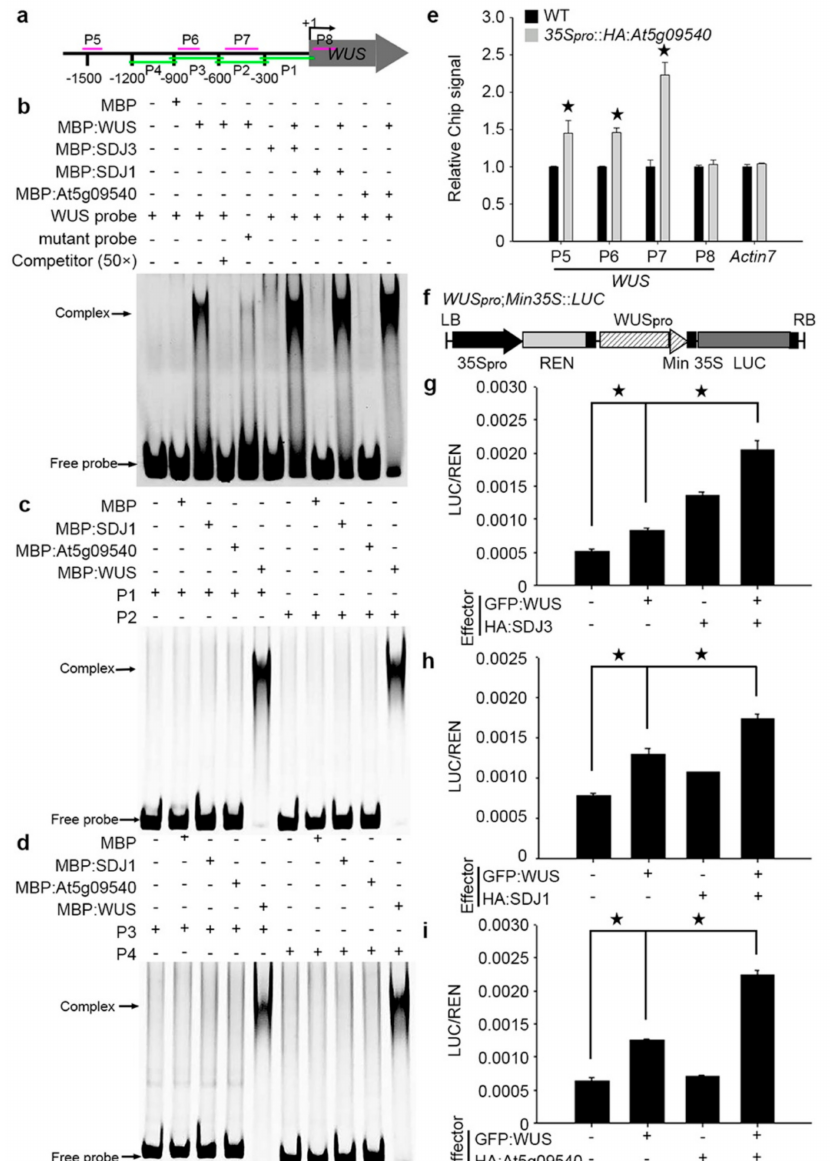
Figure 2. WUS-DnaJ complexes bind to WUS promoter and regulate WUS promoter activity. ( a ) Diagram of amplicon locations in WUS promoter. ( b ) DnaJ proteins bind to Texas red-labeled WUS promoter probe via the interaction with WUS protein as a complex in EMSA assay. The unlabeled probe was used as competitor. The TAAT box was substituted by CCCC in WUS mutant probe to abolish the binding of WUS protein. ( c , d ) SDJ1 and At5g09540 proteins failed to bind to P1( − 312 bp–+25 bp) and P2 ( − 608 bp– − 285 bp)regions ( c ) and P3 ( − 926 bp– − 580 bp)and P4( − 1203 bp– − 895 bp) regions ( d ) of WUS promoter in EMSA assay. ( e ) Chromatin immunoprecipitation of At5g09540 protein with different regions (P5, P6, P7, P8) of WUS promoter and an Actin7 promoter region in 35S pro ::HA:At5g09540 plants. P5( − 1570 bp– − 1481bp), P6( − 869 bp– − 774 bp), and P7( − 515 bp– − 340 bp) regions contain TAAT box, but not P8 (+12 bp–+121 bp) region. The ChIP signal was calculated with three independent biological replicates, Student-t test, * p < 0.05. ( f – i ) LUC/REN activity in tobacco cells co-transformed with WUSpro;min35S::LUC reporter construct and indicated effectors. ( f ) Diagram of WUSpro; Min35S::LUC reporter construct. 35S: CaMV 35S promoter; WUSpro: 2.2 Kb WUS promoter ( − 1– − 2200 bp); Min35S: 47 base pair 35S minimal element; REN: Renilla luciferase, LUC: firefly luciferase. LB/RB: T-DNA left or right border. The WUS promoter activity was significantly increased by WUS protein in combination with SDJ3 ( g ), SDJ1 ( h ), and At5g09540 ( i ), respectively. Error bar = mean ± SEM ( n = 4 biological replicates). Student-t test, * p <